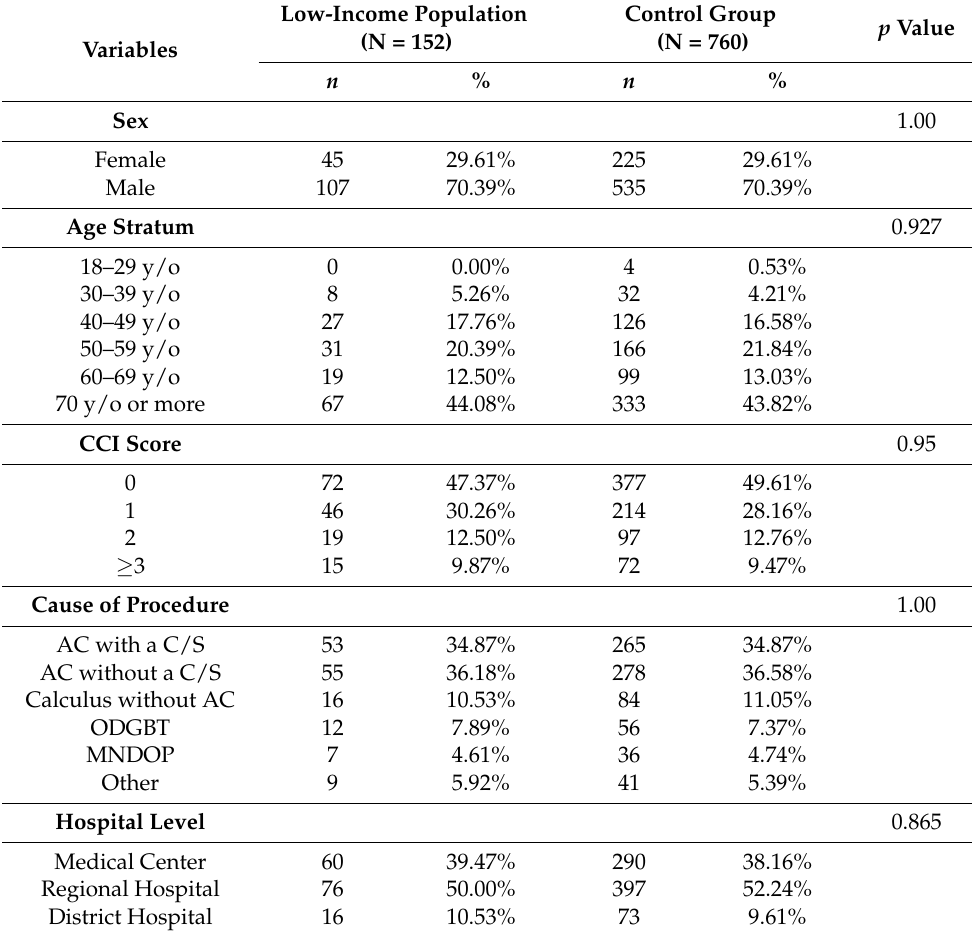
Table 2. Demographic characteristics of the patients undergoing PC after propensity score